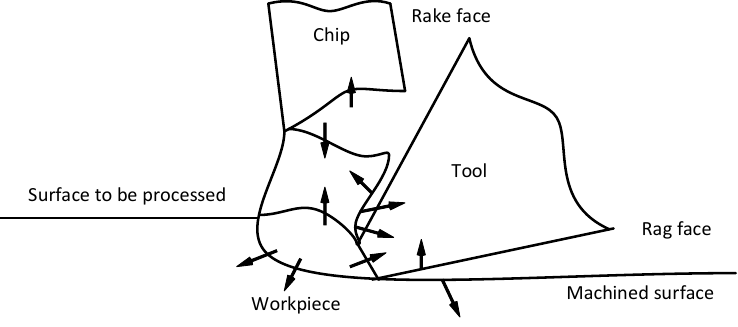
Figure 1. Sources of Acoustic Emission (AE) in machining.